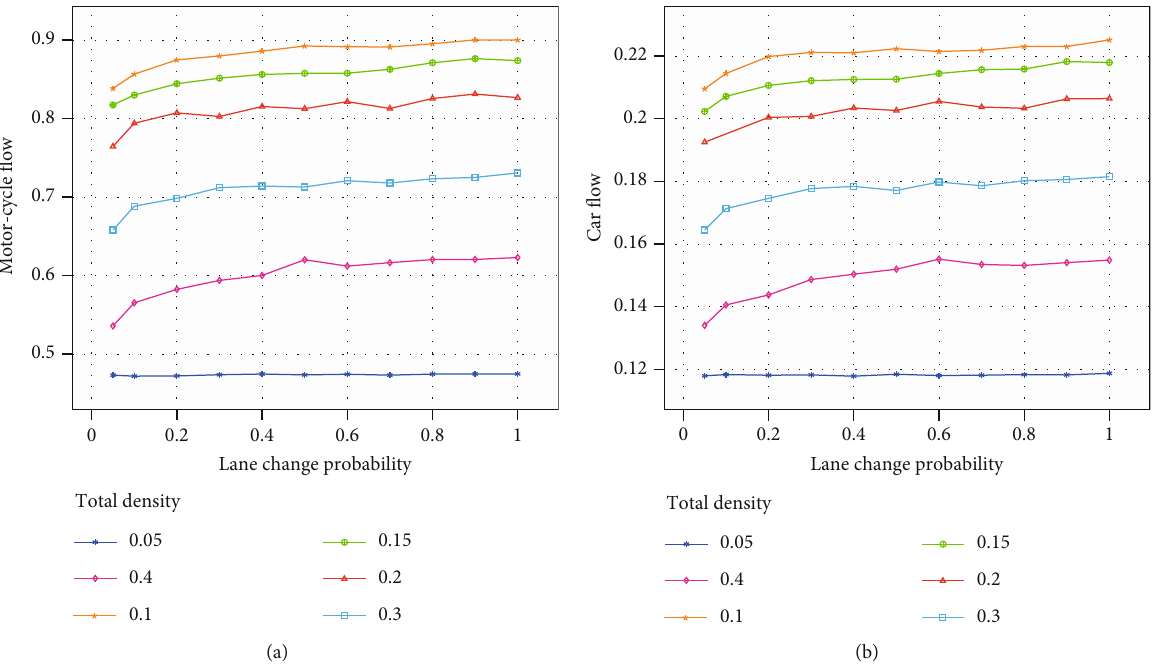
Figure 6: (a) Motorcycle fl ow v/s lane change probability diagram with sp = 0 : 25 for di ff erent total densities. (b) Car fl ow v/s lane change probability diagram with sp = 0 : 25 for di ff erent total